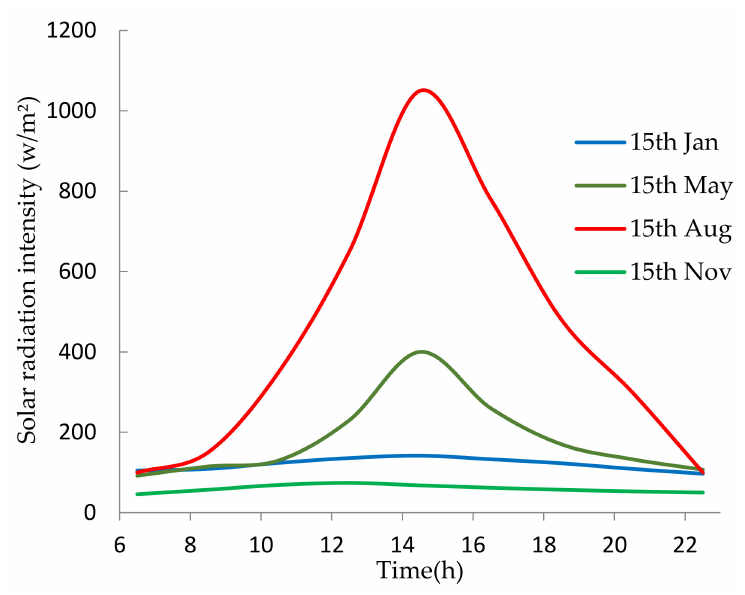
Figure 2. Solar radiation intensity in di ff erent